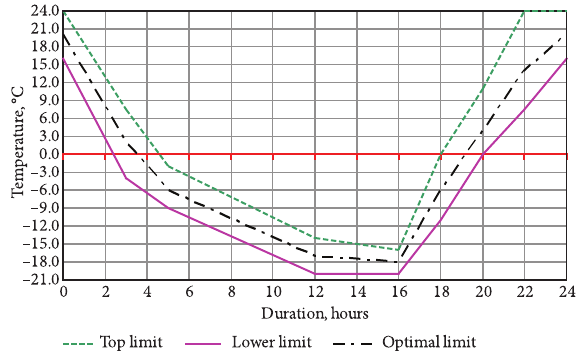
Fig. 1. The diagram of freeze-thaw cycle temperature changes in the freezing